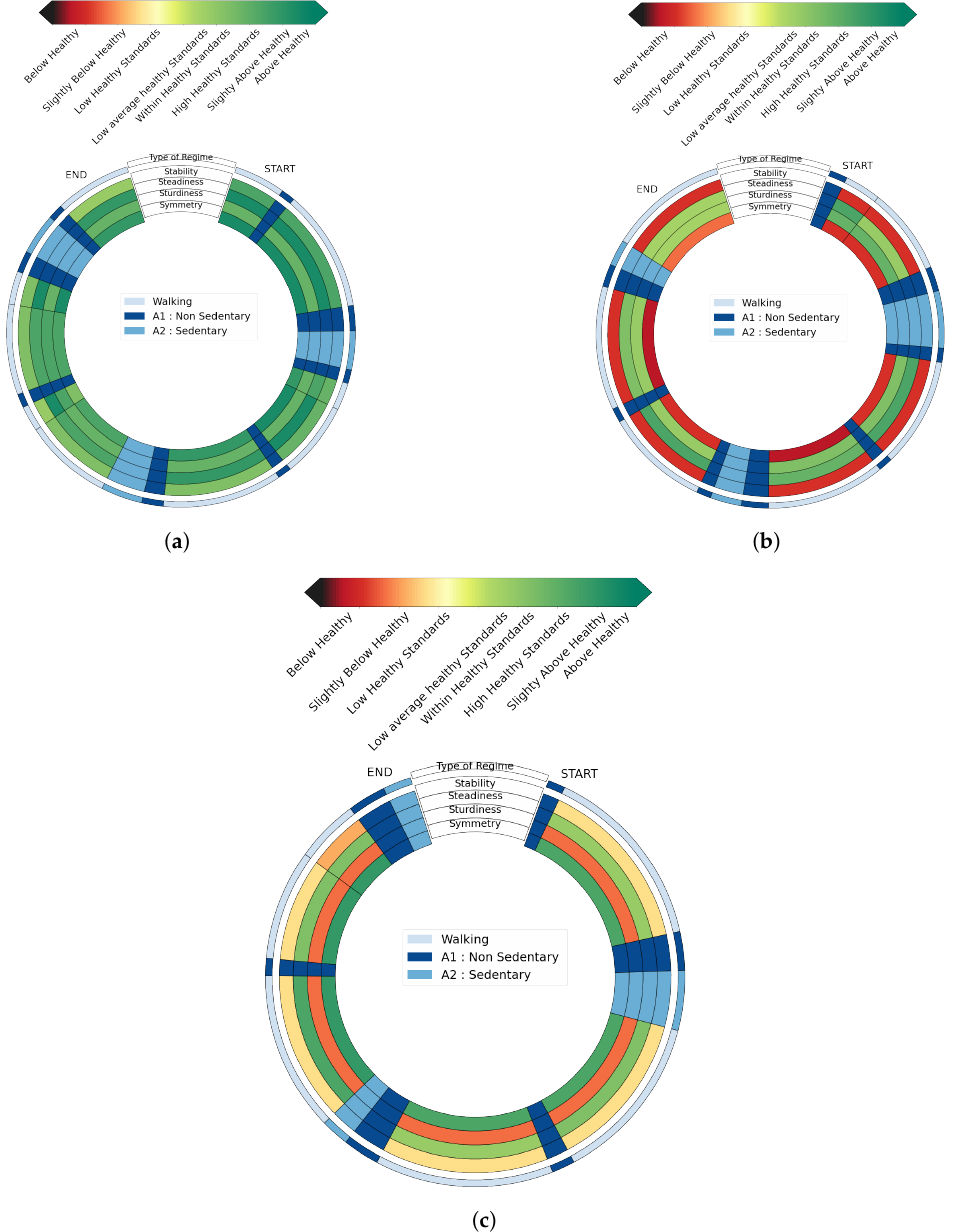
Figure 5. Graphical feedbacks from (a) HSU , (b) PSU1 , (c) PSU2